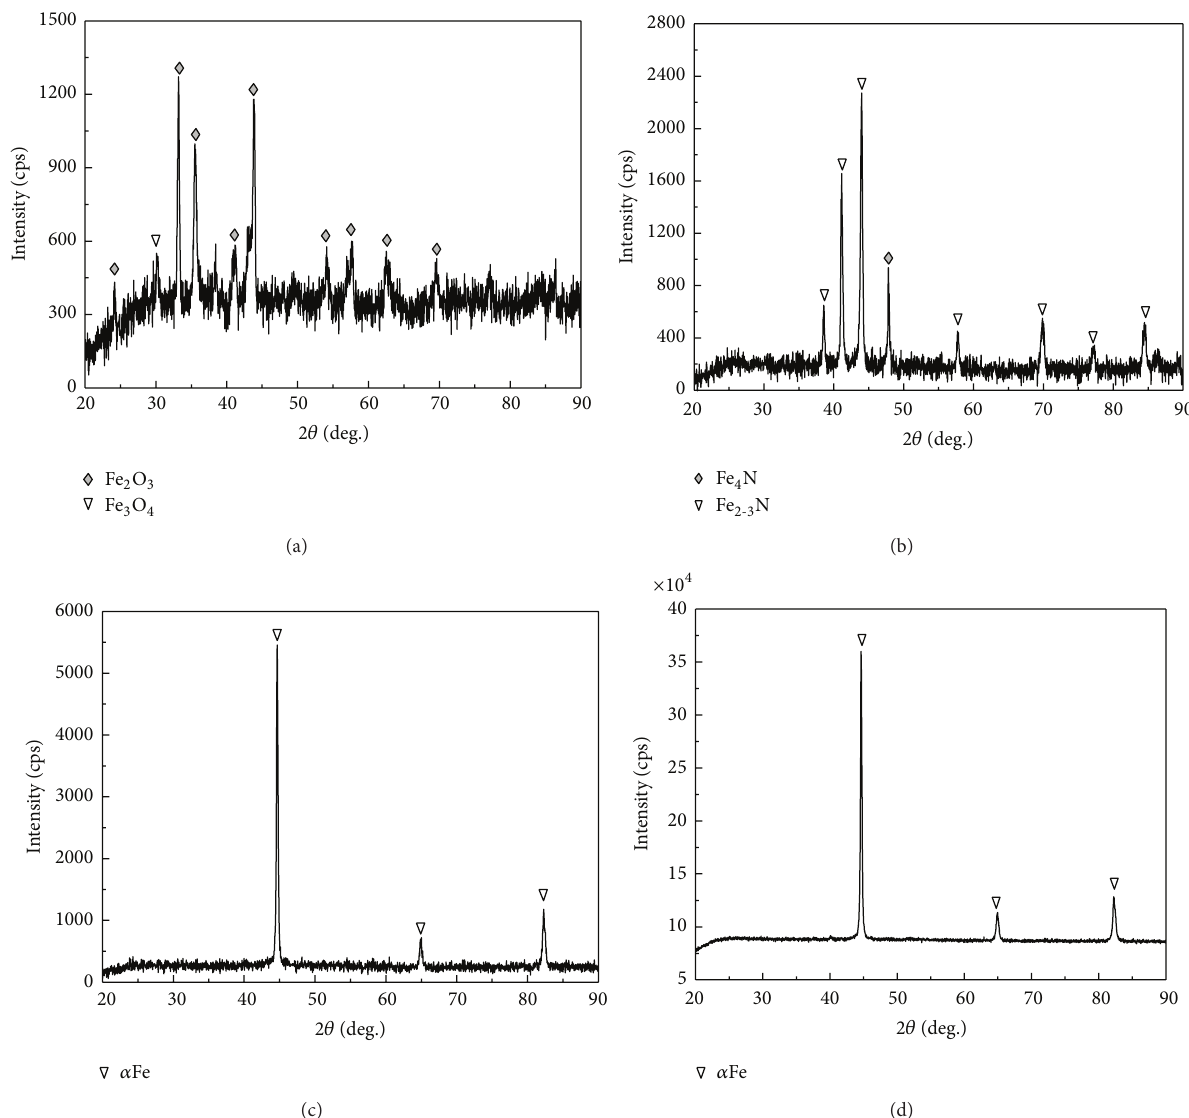
Figure 4: X-ray diffraction patterns of (a) CN, (b) CN with the oxide layer polished, (c) CNP, and (d) UCN.